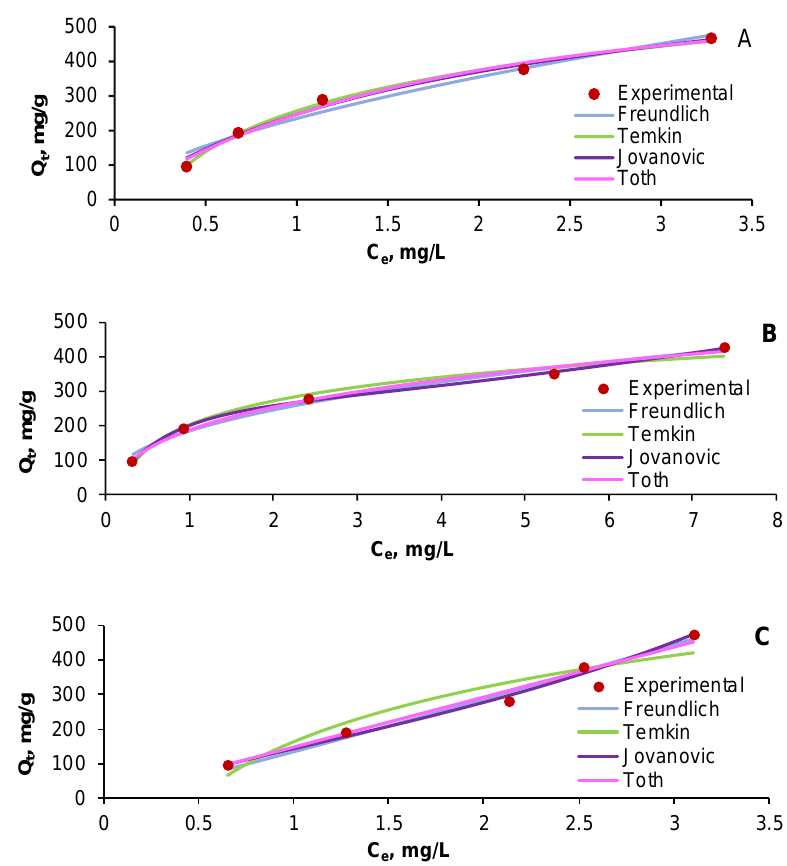
Figure 8. Equilibrium isotherms of AR ( A ), RB ( B ), and 50% AR + 50% RB ( C ) adsorption on CSCH adsorbent.